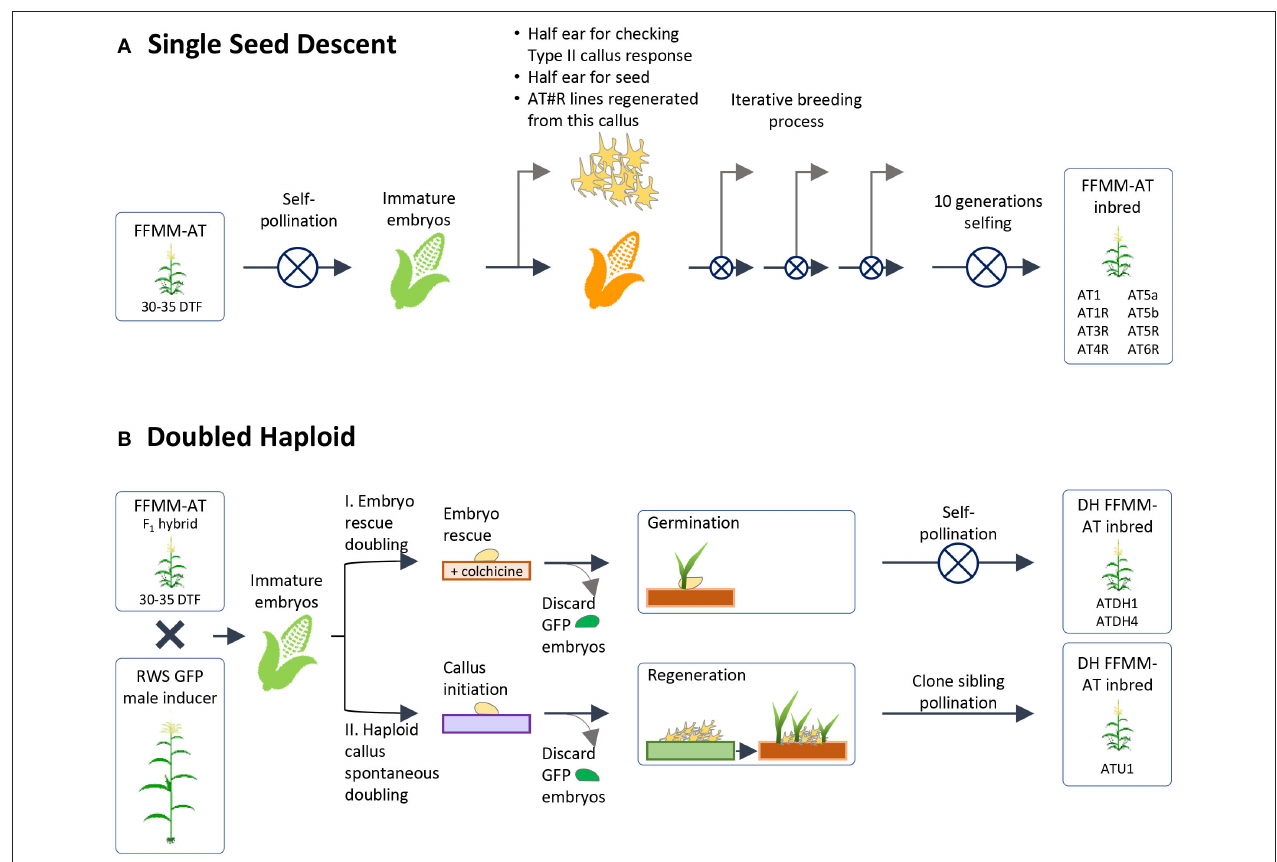
FIGURE 2 | Generation of homozygous lines. This figure depicts the two methods by which homozygous lines were produced from a heterozygous population selected for callus formation and regeneration, fast-flowering, and a Mini-Maize plant architecture. (A) Single Seed Descent method of inbreeding with further selection for callus formation and desired plant phenotype; (B) Doubled haploid methods. Starting FFMM-AT material was an F1 hybrid of lines from (A) that produced high rates of Type-II callus formation when half ears were checked and/or regenerated. DTF, days to flowering.